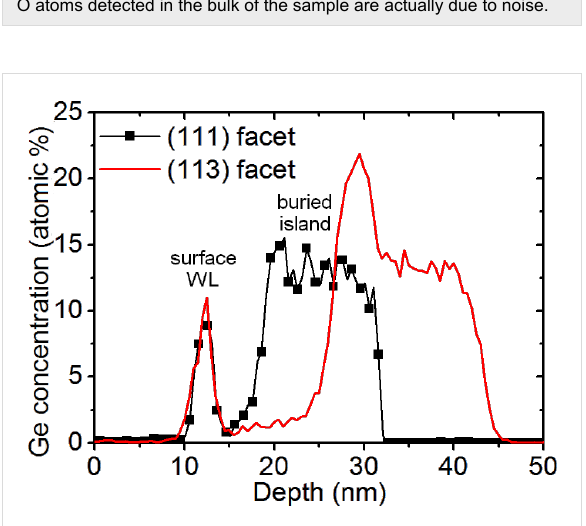
containing the core of a Ge island. Figure 8b and Figure